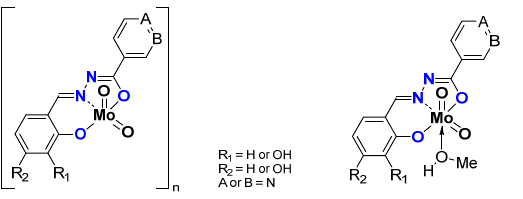
Figure 17. Schematic representation of neutral monomeric ( right ) and polymeric ( left ) Mo species studied containing the salicylaldehydato fragment in the hydrazonato ligand. Table 9. Results of carveol oxidation and selectivity toward carvone with MoO 2 L complexes from Figure 17. Substitution on General